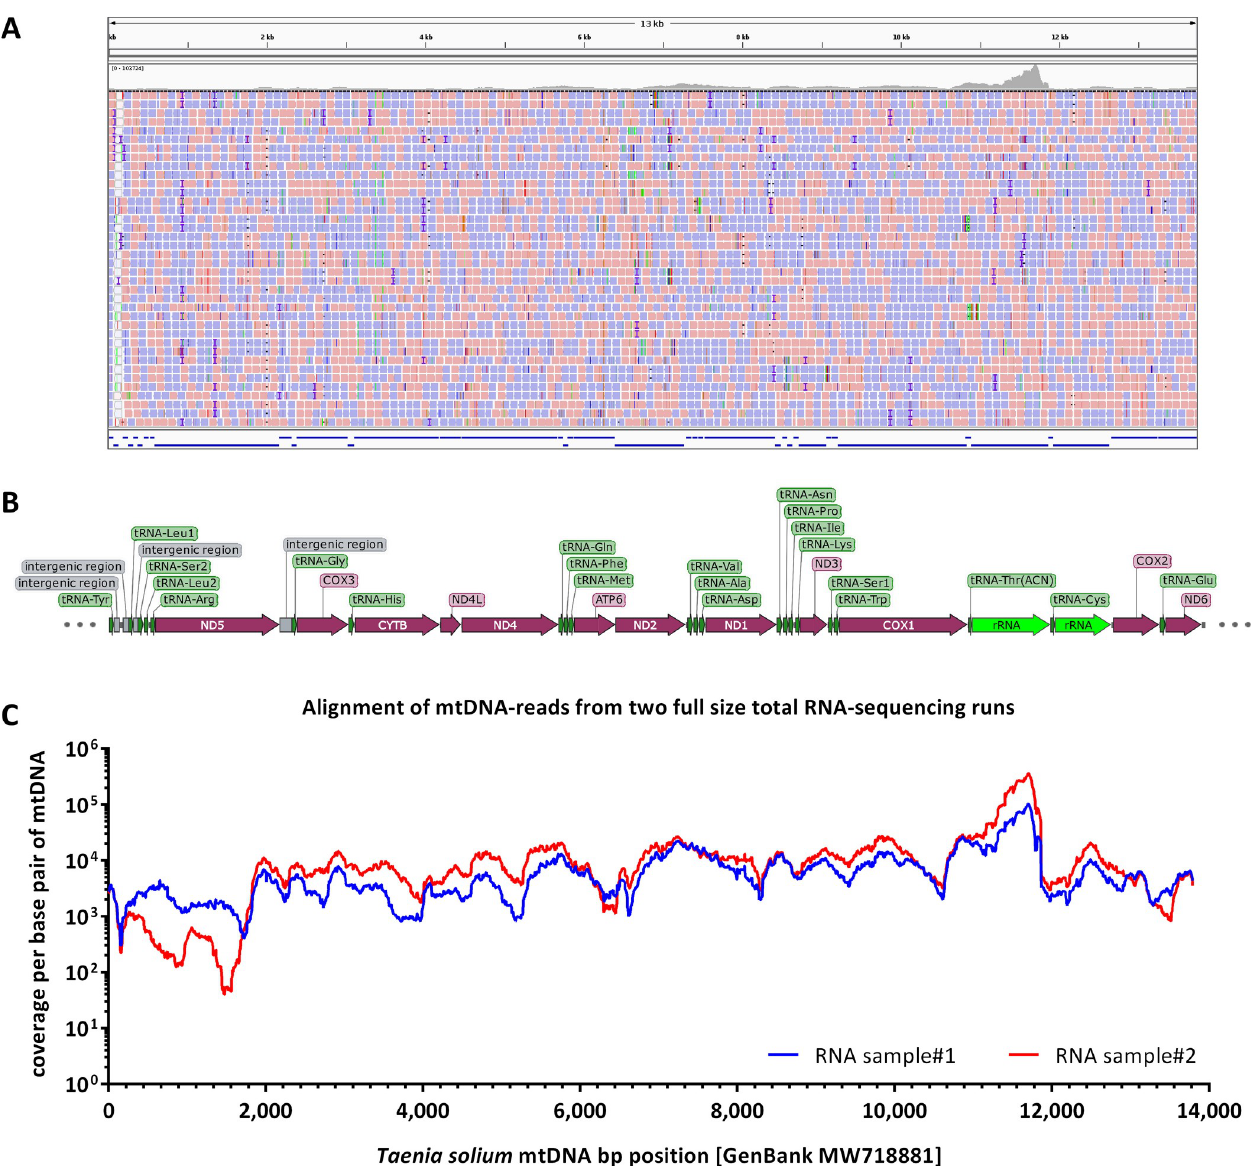
Fig 5. BWA MEM v0.7.12-alignment and per base coverage of the Taenia solium mitochondrial DNA (mtDNA). (A) Screenshot of the ungapped alignment visualized with the IGV v2.3 viewer. Pink reads represent the forward, blue reads, the reverse sequence reads. (B) Annotation of the different genes on the T . solium mtDNA. All three panels A-C are drawn to the same scale and correspond to each other. (C) Per base coverage of the different transcripts from the mitochondrial genome. The coverage fluctuates between 4 orders of magnitude with highest coverages found for the mitochondrial ribosomal RNA and lowest for the ND5-subunit of mitochondrial complex I. Both samples #1 and #2 show the identical fluctuations across the mtDNA